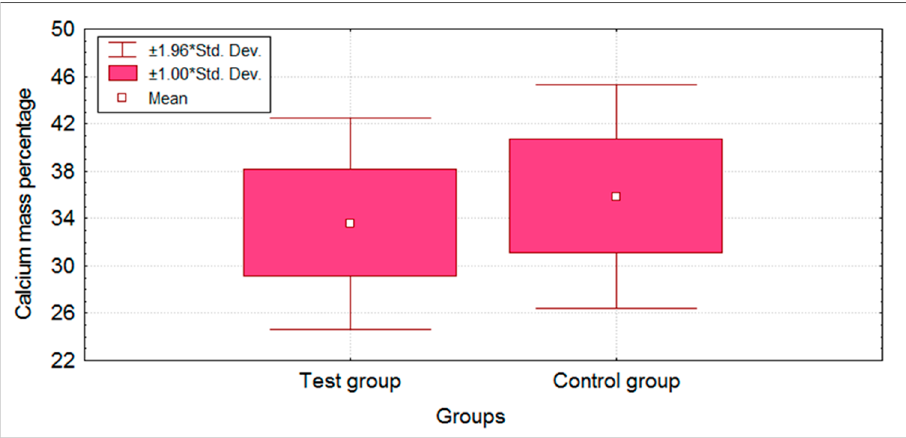
Figure 3. SEM image of the labial surface of primary tooth showing loosely packed enamel rod and inter-rod: ( a ) enamel rod; ( b ) inter-rod enamel; ( c ) rod sheath space; ( d ) perforations along the rod.